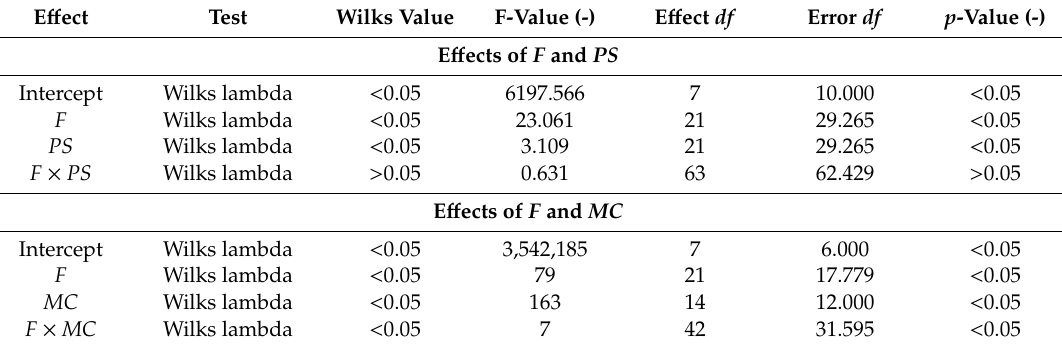
Table 3. ANOVA multivariate tests of significance of the determined parameters of ground sunflower stalk briquettes.